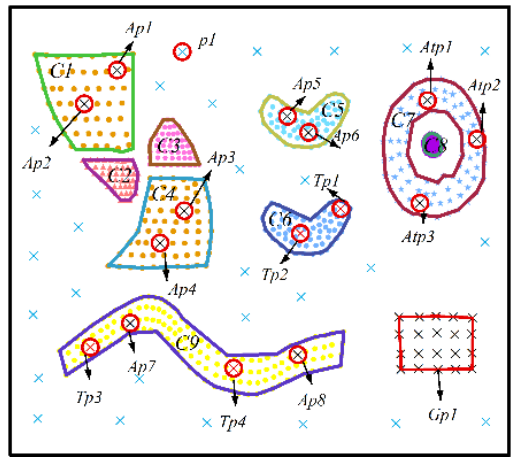
Figure 4. Spatial distribution of objects in simulated dataset 𝑆1 .